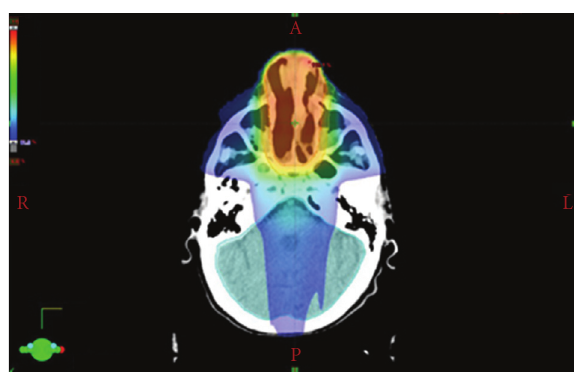
Figure 1: Radiotherapy planning I . IMRT plan with the planning target volume (PTV) in one CT cross section, red colours indicate a higher dose; a steep dose gradient can be achieved by using fluence modulation with a multi leaf collimator. Normal tissues are optimally